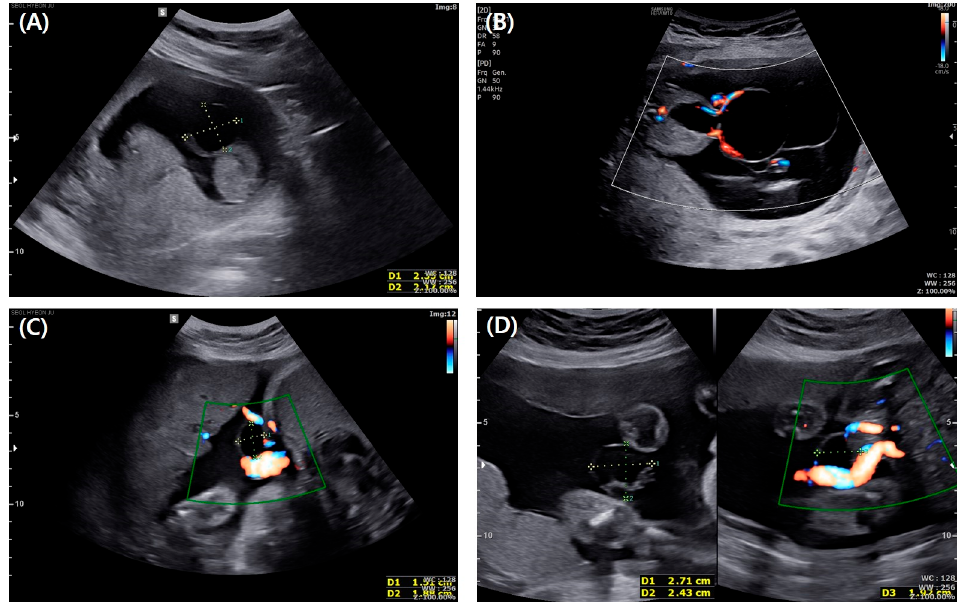
Figure 1. ( A ) Sonographic finding of the urachal cyst at the gestational age of 13 + 4 weeks shows a 2.4 cm well–defined oval–shaped anechoic cyst located at the proximal part of the umbilical cord. ( B ) Sonographic finding of the urachal cyst at the gestational age of 17 + 4 weeks shows the size of the cyst increased to 5.4 cm, with a newly appeared 3 cm–sized cyst inside the initial cyst. ( C ) Sonographic finding of the urachal cyst at the gestational age of 25 weeks shows the size of the cyst has decreased to 2.7 cm. ( D ) Sonographic finding of the urachal cyst at the gestational age of 32 weeks shows it became 1.8 cm in size.